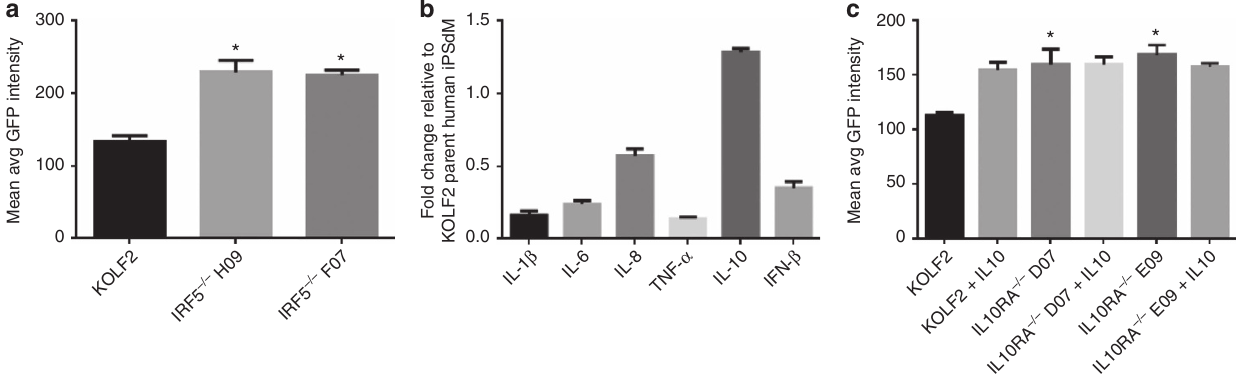
Figure 7 | C. trachomatis infection of human iPSdM CRISPR/Cas9 mutants. ( a , c ) Level of GFP-tagged C. trachomatis infection of human iPSdM CRISPR/ Cas9 mutants after 48h. Results are the averages from three independent measurements ± s.d. using the Cellomics CellInsight NXT. ( b ) Production of cytokines from the IRF5 (cid:2) / (cid:2) mutant. Results are the average from three biological replicates assessed using the Luminex Multiplex and shown as fold change relative to expression of each cytokine in KOLF2 parent iPSdMs. *Represent statistically significant different ( P o 0.05) between parent and mutants as determined using two-way ANOVA. Equal numbers of WT and mutant cells were seeded for each